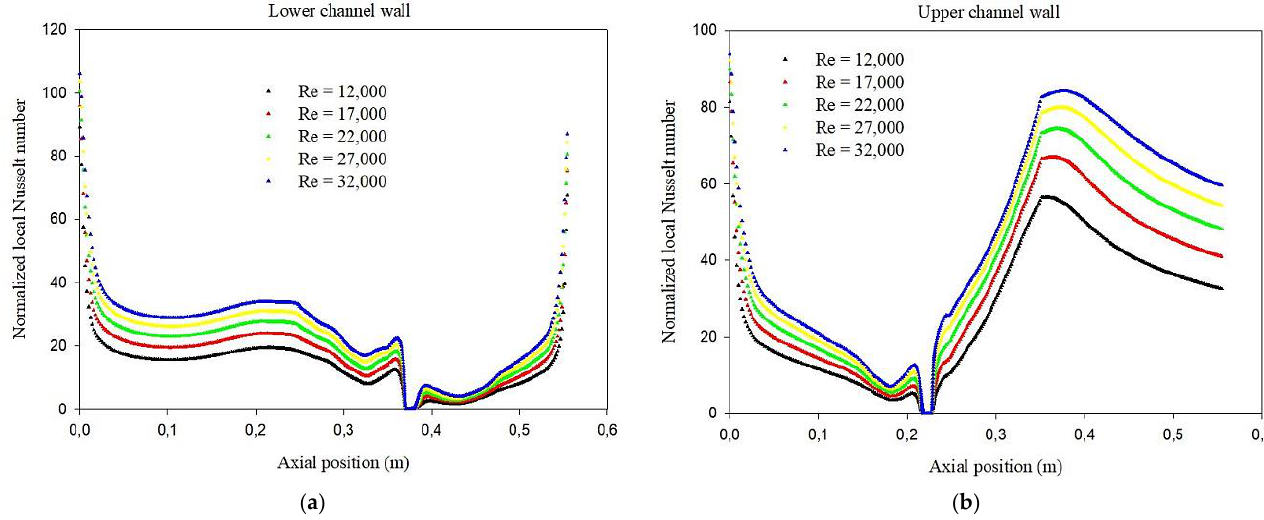
Figure 13. Dimensionless local Nusselt number vs. Re. at the ( a ) lower; and ( b ) upper surfaces of the exchanger.